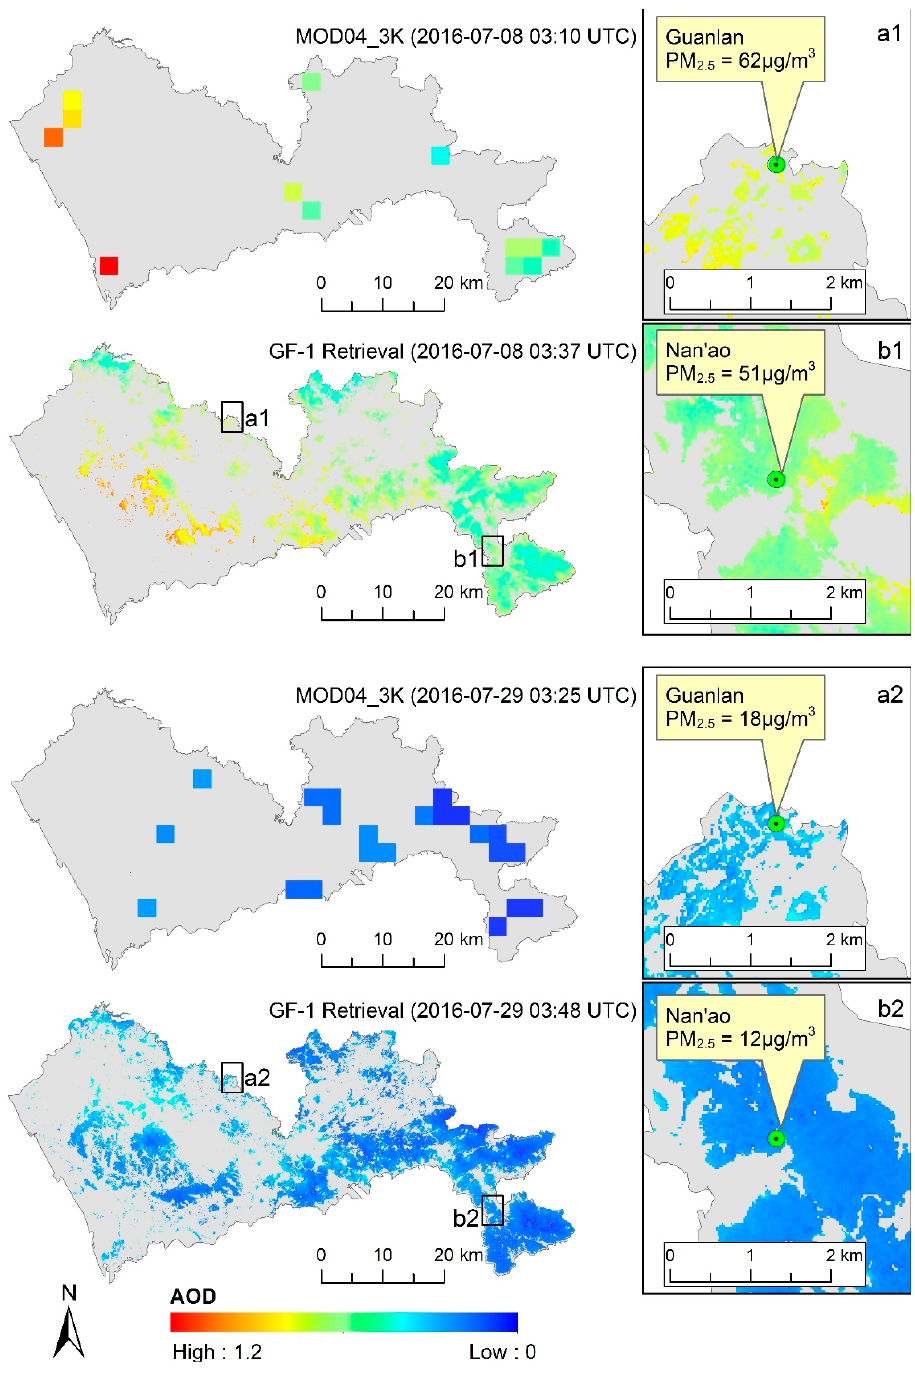
Figure 2. Examples of the derived Gaofen-1 (GF-1) aerosol optical depth (AOD) in Shenzhen City compared with MOD04_3K AOD on two dates: 8 July 2016 (a polluted day) and 29 July 2016 (an unpolluted day). The grey areas are bright pixels without derived AOD data. Panels at the right are enlarged images of areas around two air monitoring stations.